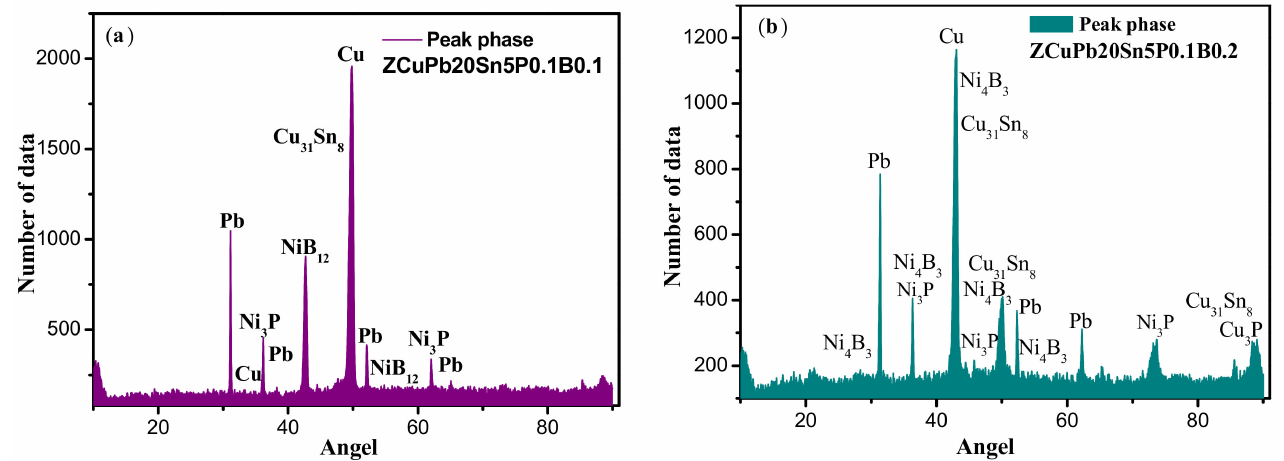
Figure 7. XRD analysis of the ZCuPb20Sn5-xB alloy. ( a ) ZCuPb20Sn5-0.1B; ( b )